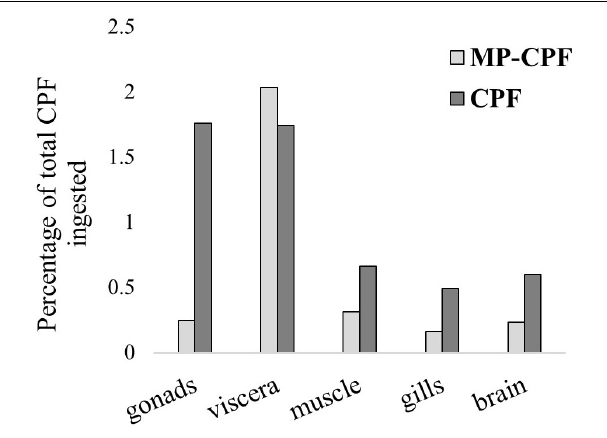
FIGURE 2 | CPF transfer to fish, expressed as the ratio ( × 100) between the total amount of CPF measured in organs (ng) and the total amount of CPF ingested via Artemia (ng; theoretical values). CPF was quantified in one fish pool ( n = 3) and two fish pools ( n = 4), for the MP-CPF and CPF groups, respectively.